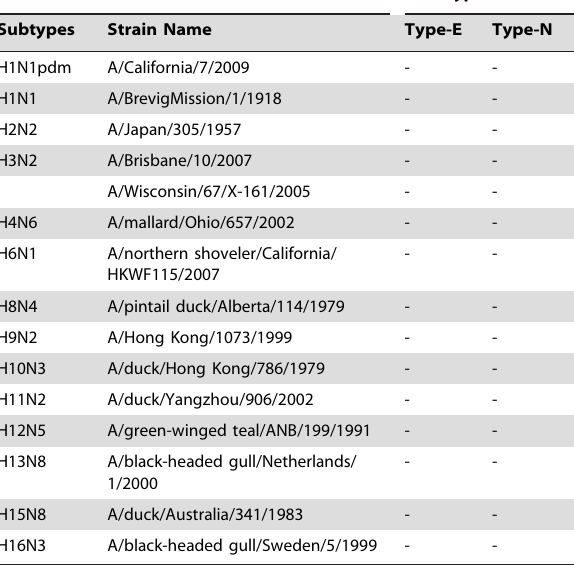
Table 7. Specificities of H5 FLIC for non-H5 subtypes of recombinant HA